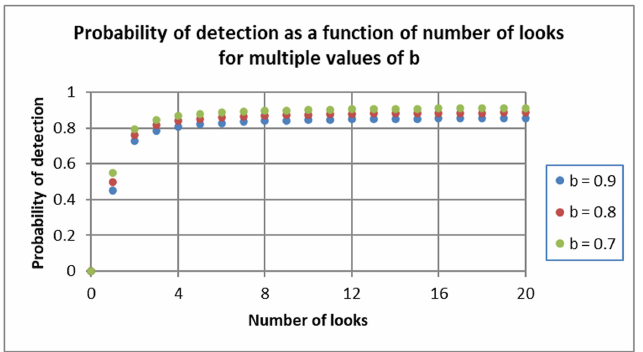
Figure 18. Probabilityofdetection asafunctionofnumber of looks assuming g ð x Þ ¼ g a ; b ð x Þ ¼ a þ b $ sin ð x Þ 2 with a ¼ 0 : 1 and ¼